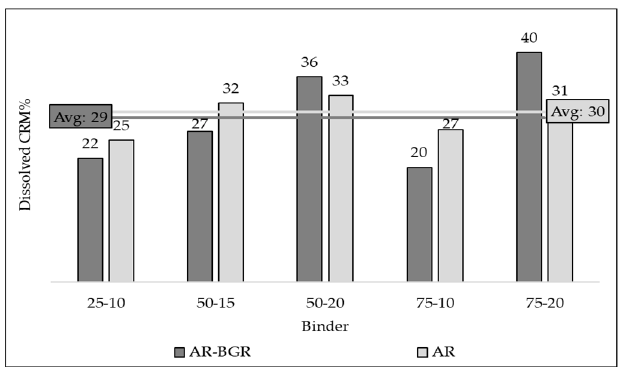
Figure 6. Crumb rubber modifier (CRM) dissolution: Asphalt–rubber–guayule binders vs. asphalt– rubber binders.